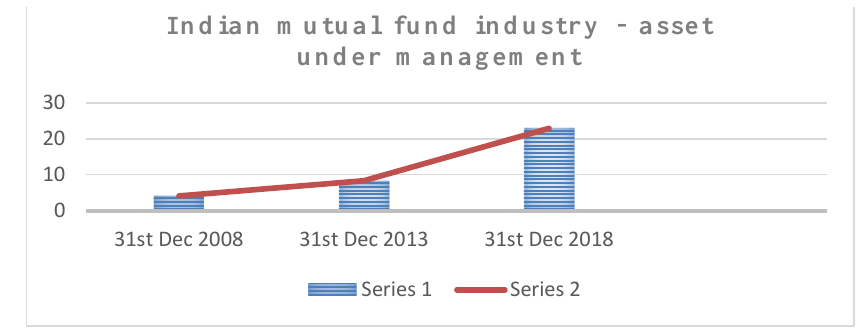
Fig. 3: Indian mutual fund industry; Source: AMFI website